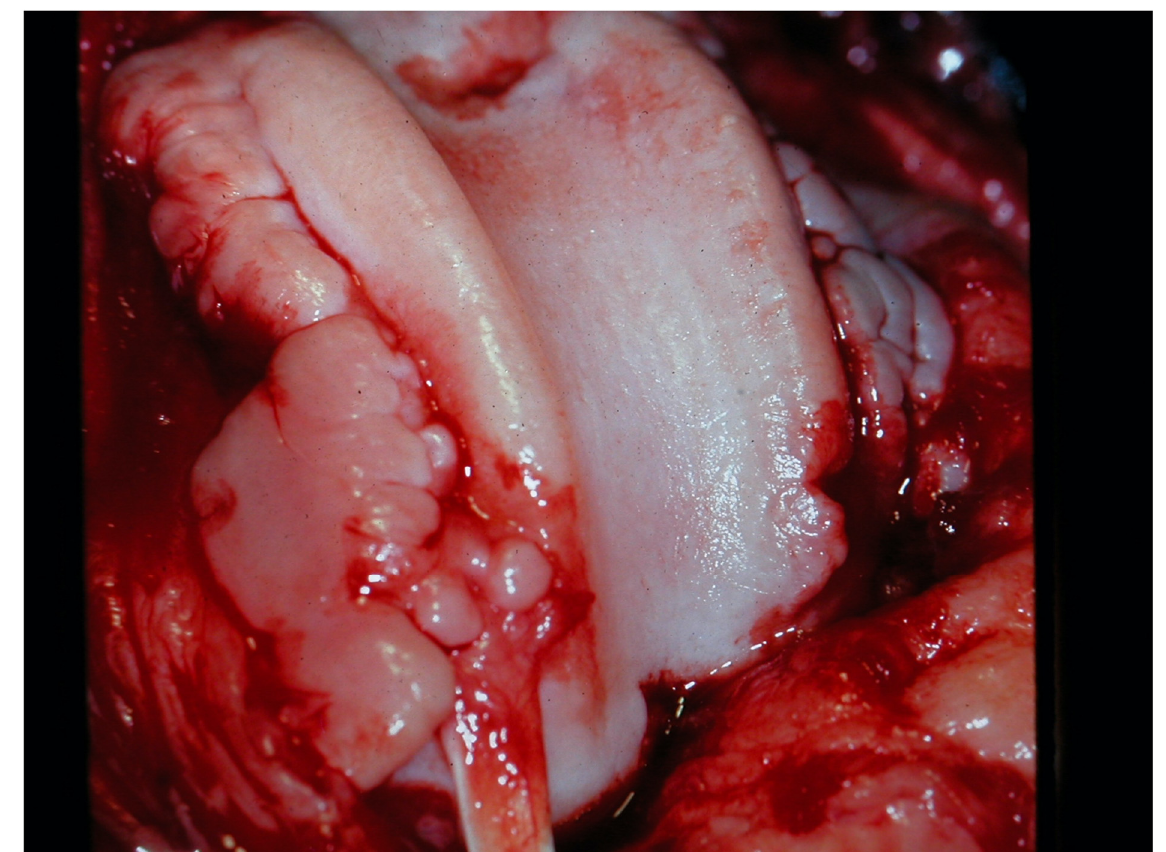
Figure 3. Late-stage OA in a dog 4 months after untreated CCLR; note the bilateral intra-capsular osteophytes and cartilage erosion on femoral trochlear ridges; the tendinous structure is the insertion of the extensor digitorum pedis longus muscle (image by the author).